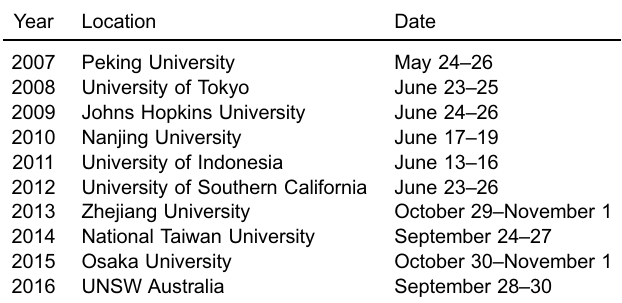
Table 4. Annual APRU Global Health Workshops Table 3. APRU GHP Advisory Group Members for 2014 – 2016